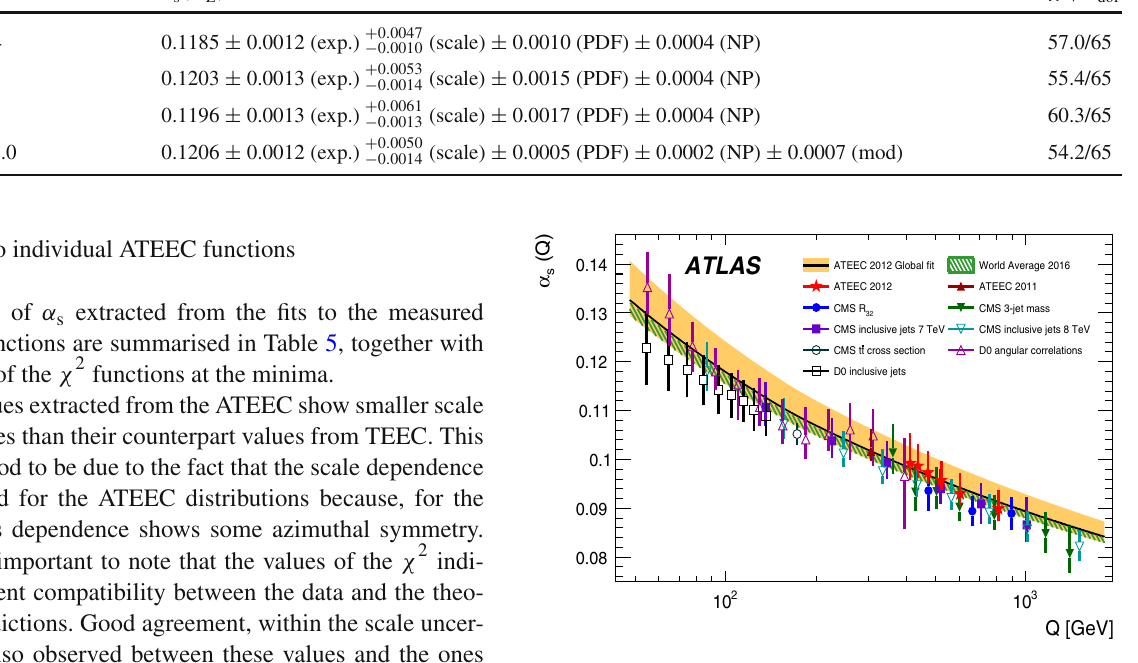
Table 7 The results for α s from fits to the ATEEC using different PDFs. The uncertainty referred to as NP is the one related to the non-perturbative corrections. The uncertainty labelled as ‘mod’ corresponds to the HERAPDF modelling and parameterisation uncertainty PDF